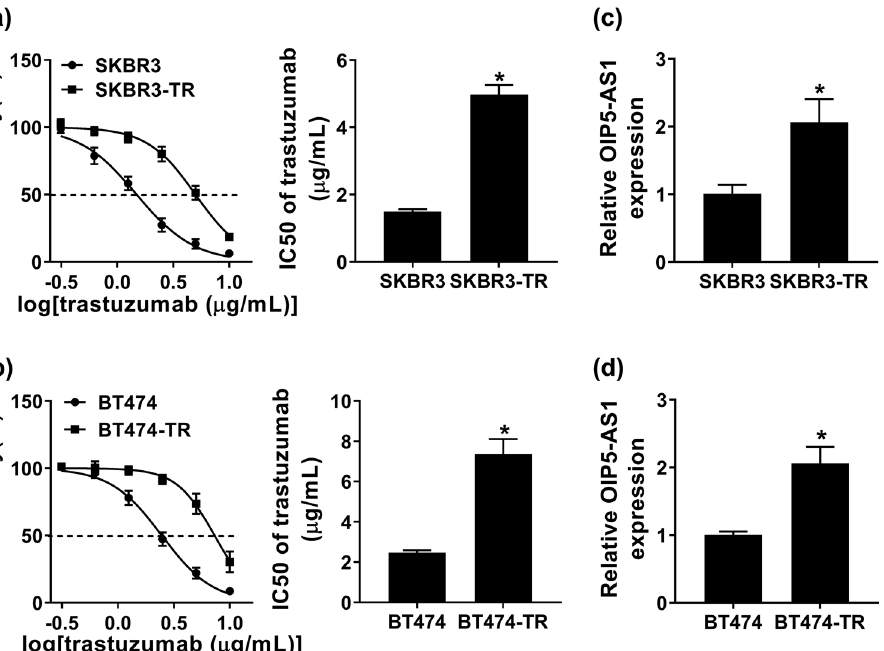
Figure 1: OIP5 - AS1 is up - regulated in trastuzumab - resistant breast cancer cells. ( a and b ) CCK - 8 Analysis of the viability of parental and resistant cell in combination with increasing concentrations of trastuzumab ( 0.3125 – 10 μ g/mL ) as well as the IC 50 values of cells to trastuzumab. ( c and d ) Analysis of levels of OIP5 - AS1 in SKBR3 and SKBR3 - TR cells as well as in BT474 and BT474 - TR cells. * P <